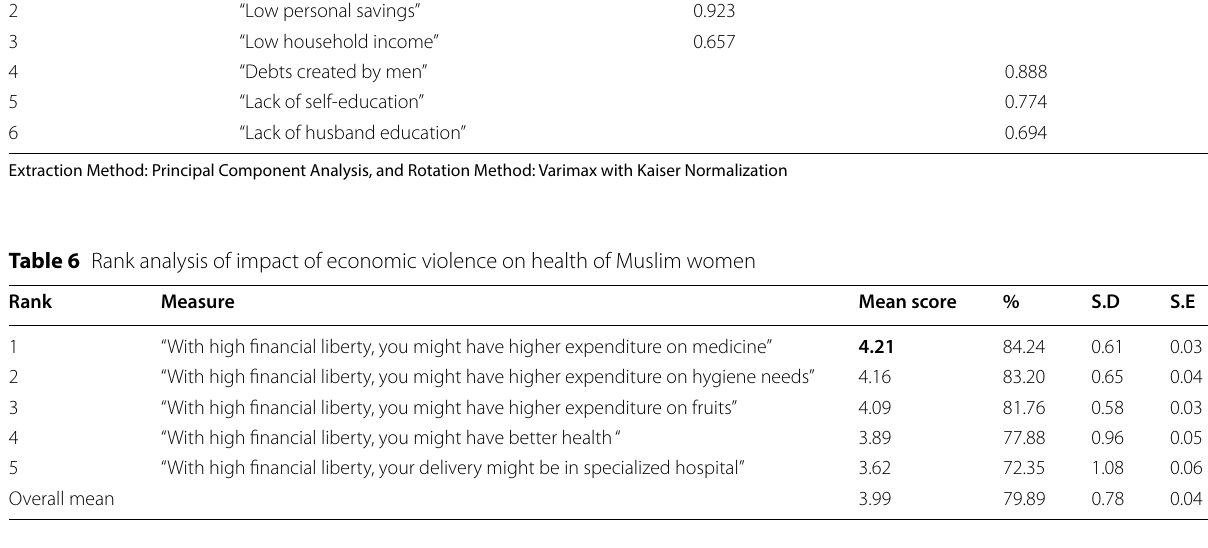
Table 5 Rotated component matrix S. No.